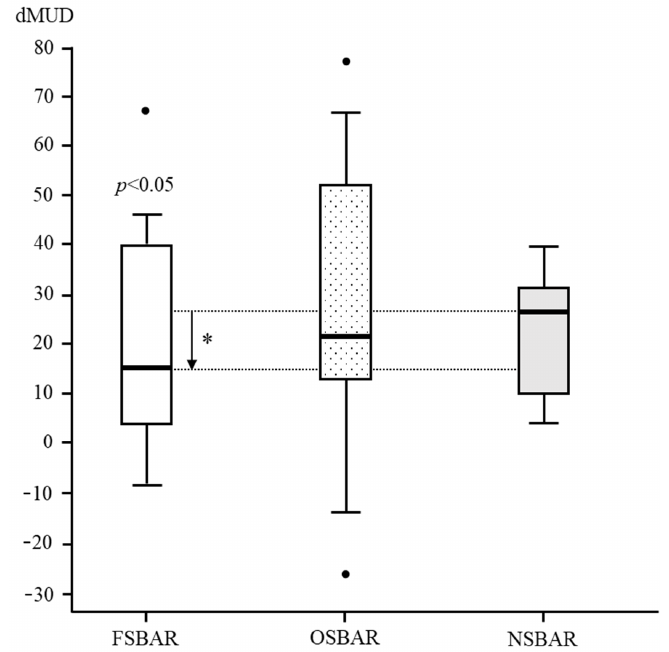
Figure 2. dMUD comparison between FSBAR, OSBAR, and NSBAR interventions. dMUD compar- ison between the three treatment groups: 1. fetal–endoscopic (FSBAR), 2. open fetal (OSBAR), and 3. neonatal (NSBAR) intervention. The x - axis indicates FSBAR, OSBAR, and NSBAR, intervention groups. The y - axis indicates intraindividual dMUD values per cohort. dMUD values reflect the im- pact of the MMC on neuromuscular integrity. A lower dMUD value implicates less impact by the MMC and thus better preserved segmental muscle integrity caudal to the MMC (for a methodologic explanation, see figure 1). Quantitative dMUD values were significantly lower (better) in the FSBAR than the NSBAR group, p < 0.05. Differences between OSBAR versus NSBAR and between FSBAR versus OSBAR were not statistically significant. Box plots mark the first and third quartiles; whisk- ers represent data points 1.5 times the interquartile range below and above the first and third quar- tiles. dMUD= (MUD-caudal to the MMC) minus (MUD-cranial to the MMC). Abbreviations: MMC = myelomeningocele; FSBAR = fetal intervention technique by the endoscopic approach; OSBAR = fetal intervention technique by the open approach; NSBAR = neonatal MMC closure; MUD = muscle ultrasound density; dMUD = the difference in muscle ultrasound density over the MMC (*= p ˂ 0.05; Dots represent outliers.).